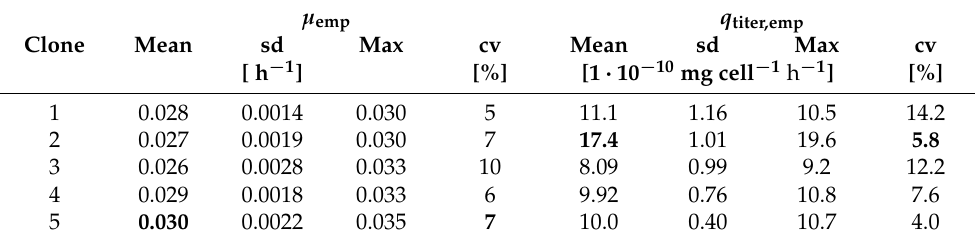
Table 3. Mean, standard deviation (sd), coefficient of variation (cv) and maximum of empirical growth rate µ emp and mean, standard deviation, coefficient of variation and maximum of empirical production rate q titer,emp for ‘clone1’ to ‘clone5’ based on data from a 13 weeks-stability study. µ emp q titer,emp Clone Mean sd Max cv Mean sd Max cv [ h − 1 ] [%] [1 · 10 − 10 mg cell − 1 h − 1 ] [%] 1